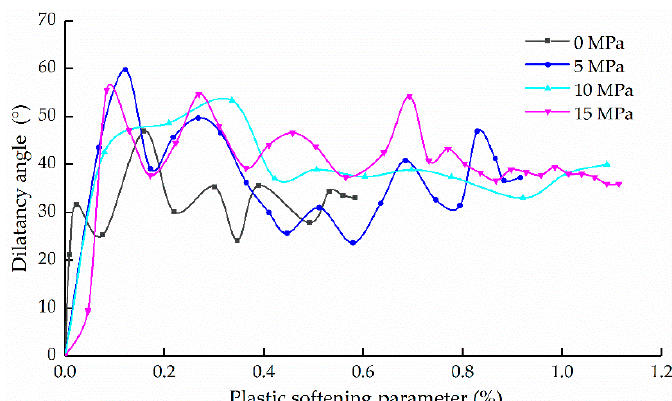
Figure 6. Dilatancy angle vs. the plastic softening parameter under different confining pressures. The fitting coefficients in Equation (12) under different confining pressures are given in Table 2. Table 2. Fitting coefficients for Equation (12) under different confining pressures.